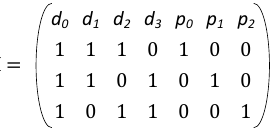
Figure 2. Parity check matrix of a (7, 4) binary Hamming code.